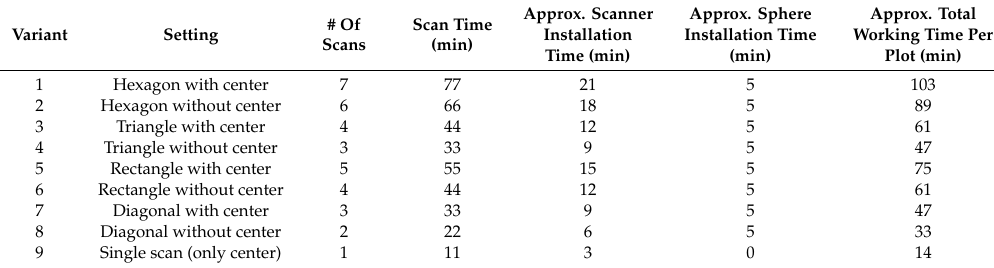
Table 2. Overview of scan variants with respect to geometric setup, number of scans, and necessary working time.